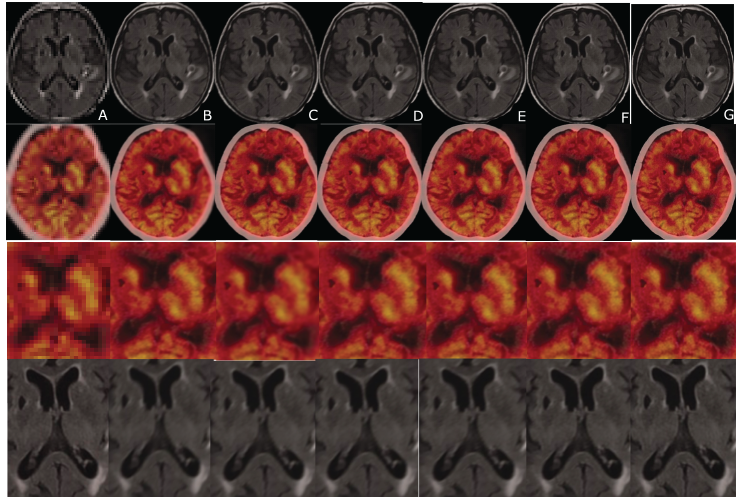
Figure 9. An example of CT and FDG-PET data sets. From left to right: ( A ) LR input; ( B ) B-spline Cubic interpolation; ( C ) Non-Rigid Multi-Modal 3D Medical Image Registration Based on Foveated Modality Independent Neighbourhood Descriptor [25]; ( D ) Enhanced deep residual networks for single Image Super-Resolution [13]; ( E ) Image super-resolution using very deep residual channel attention networks [14]; ( F ) Residual dense network for Image Super-Resolution [15]; ( G ) the presented algorithm. The 3rd and the 4th row: the cropped and zoomed